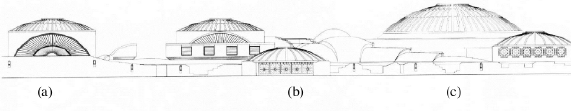
Figure 6. Elevation drawing of National Ballet School.